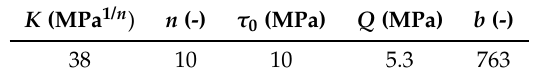
Table 2. Material parameters identified from the macroscopic tensile